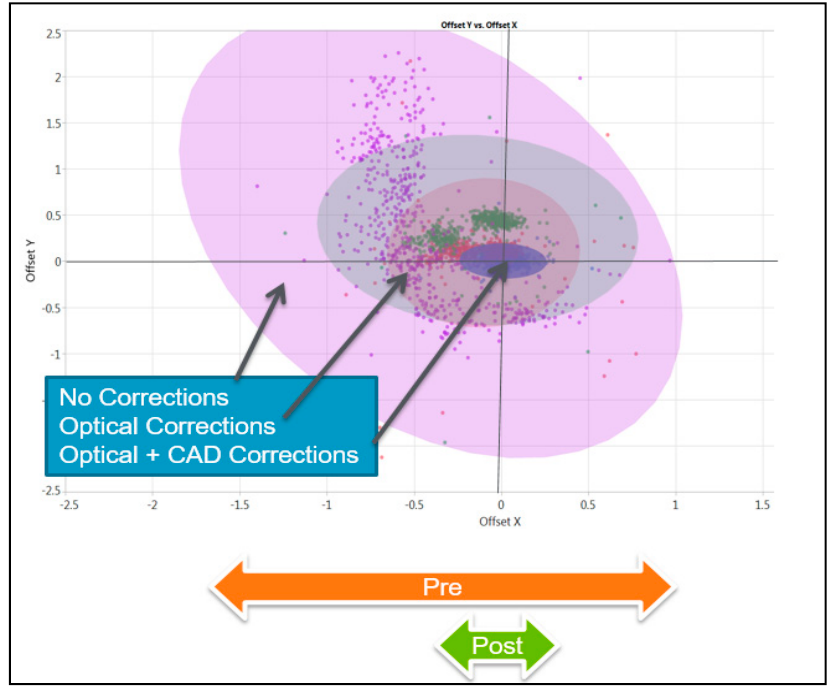
Figure 8. Spread of critical defects and corrections made using the computer aided design tool and optical technologies.